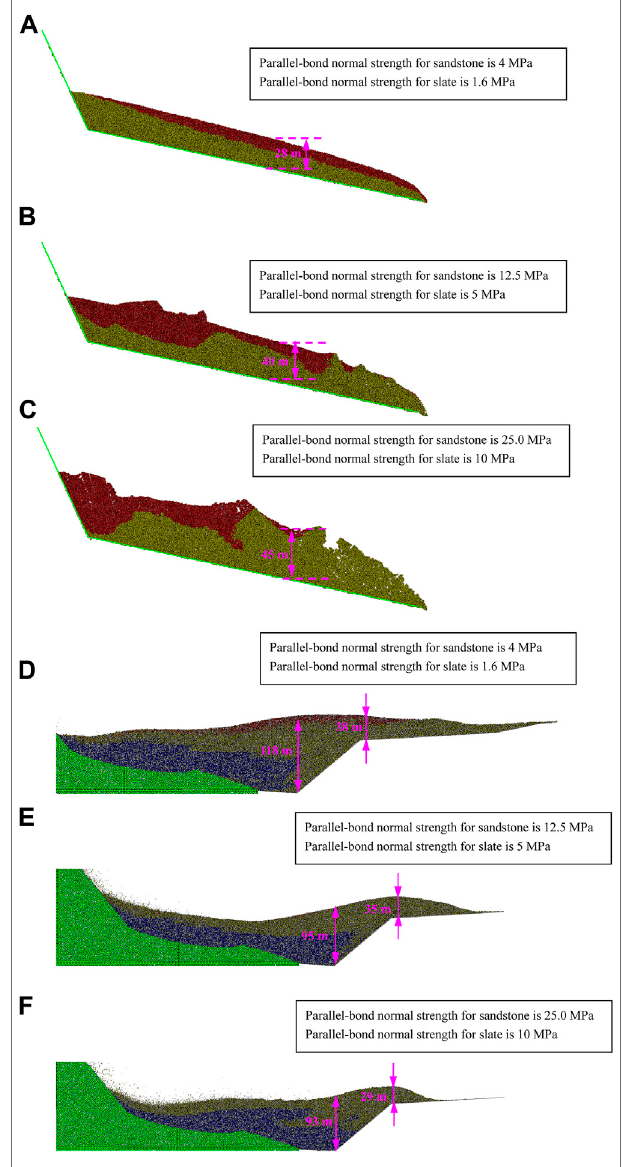
FIGURE 13 | (A – C) In fl uence of bonding strength on the landslide deposit accumulation in the upper source area. (D – F) In fl uence of bonding strength on the landslide deposit accumulation in the valley of the Duba River.